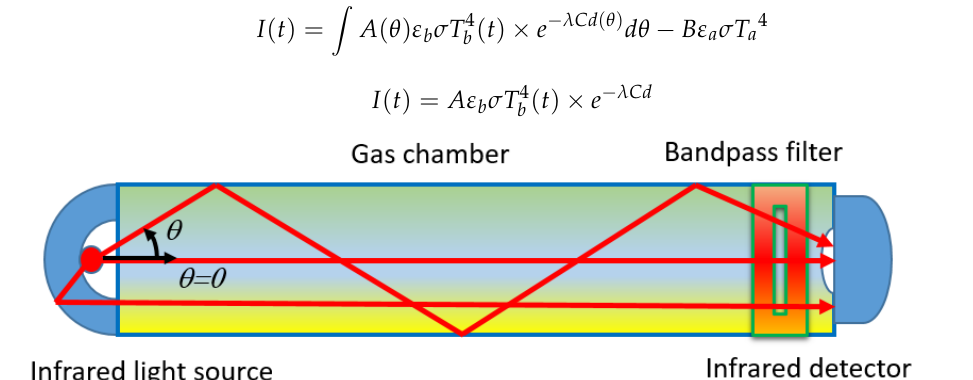
Figure 1. Schematic diagram of NDIR system.